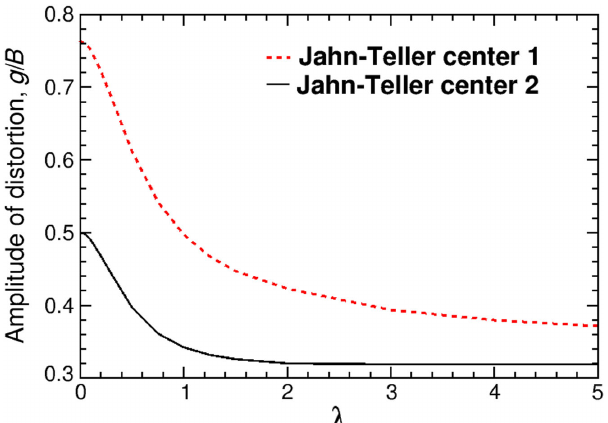
FIG. 8. The amplitude of the distortion for a pair of Jahn-Teller centers as a function of λ ( g ¼ B ¼ 1 ). There are four equivalent distortions of two octahedra for λ ¼ 0 , see Fig. 7(a). Top and bottom octahedra are distorted differently in each case (due to competition between local JT and coupling between them). Increase of the SOC strength reduces this